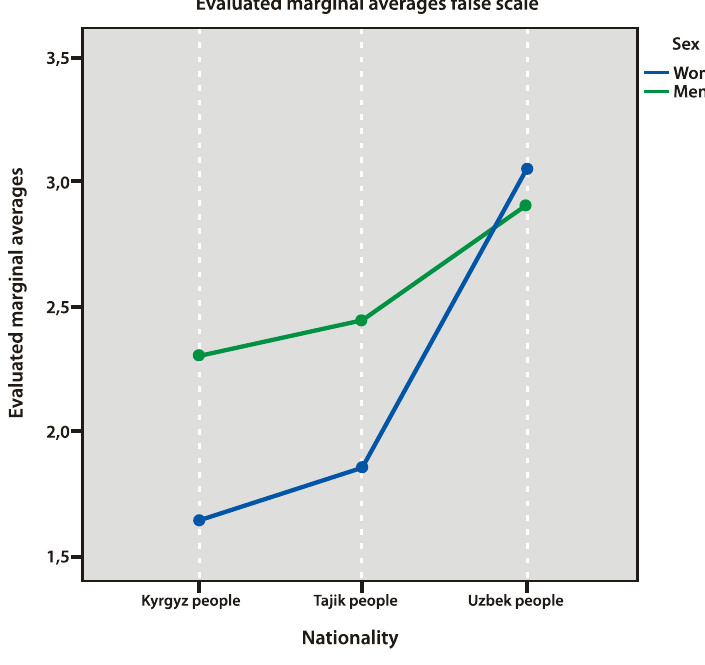
Figure 10. False scale factors.